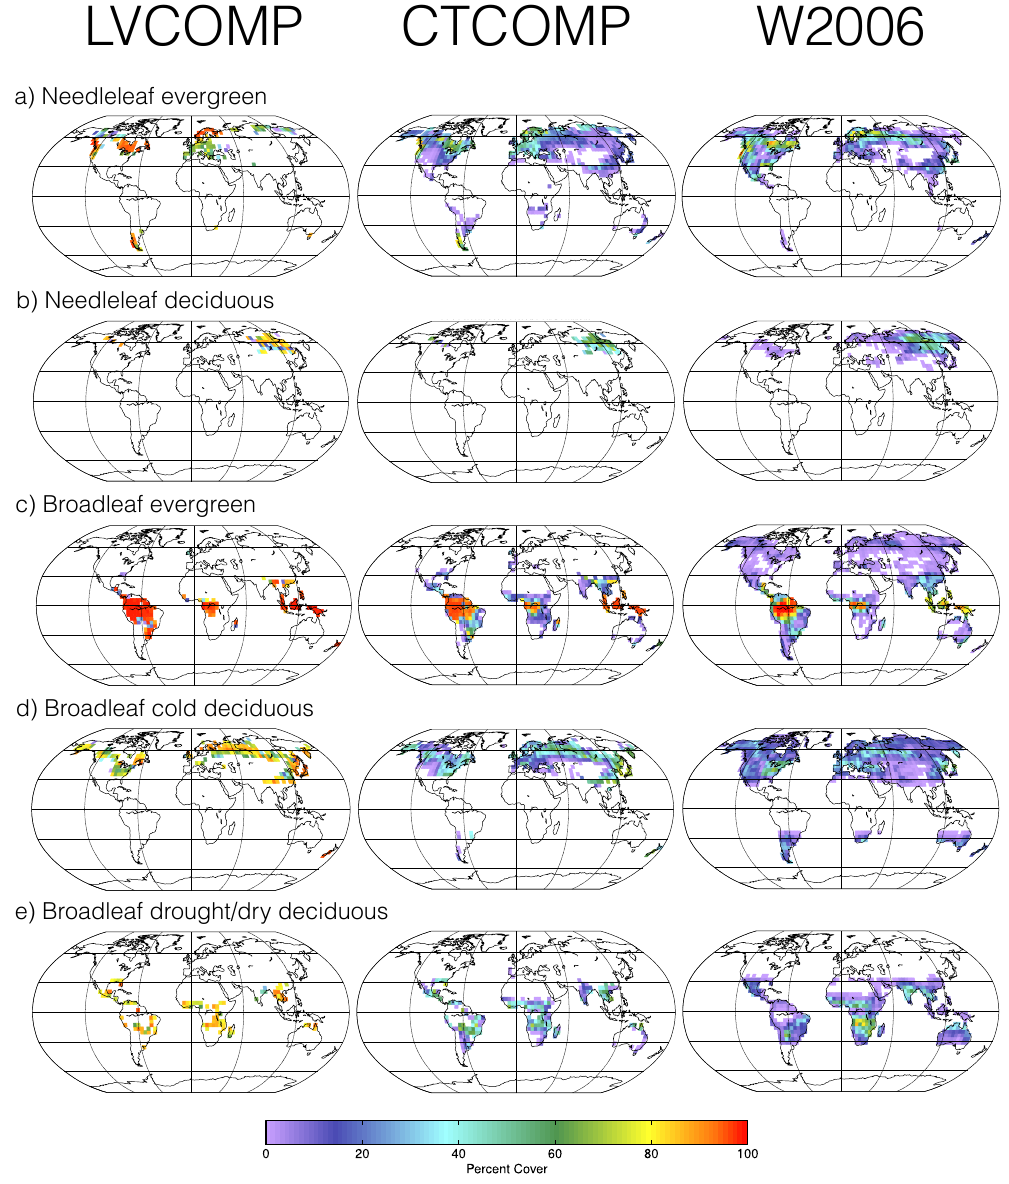
Figure 3. Comparison of simulated fractional coverage of tree PFTs in the LVCOMP (based on the original L–V equations, left column) and CTCOMP (based on modified L–V equations, middle column) simulations with the observation-based estimate from the modified Wang et al. (2006) data set corresponding to year 1861 (right